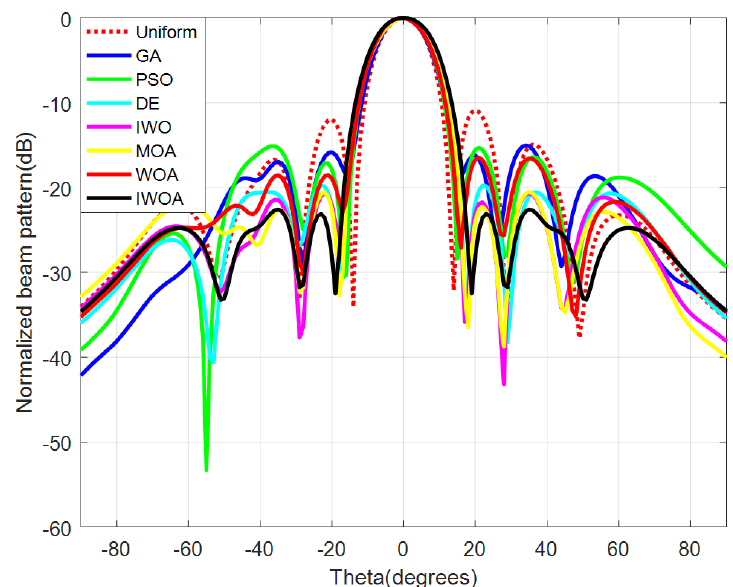
Figure 12. The 2D beam patterns of the 64-element planar phased